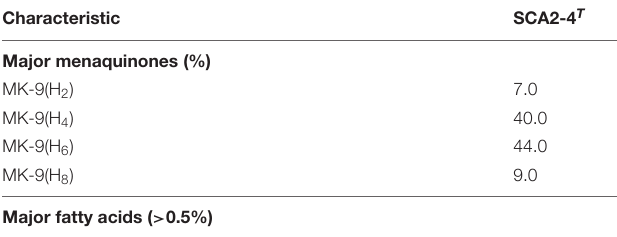
TABLE 3 | Chemotaxonomic characteristics of strain SCA2-4 T .